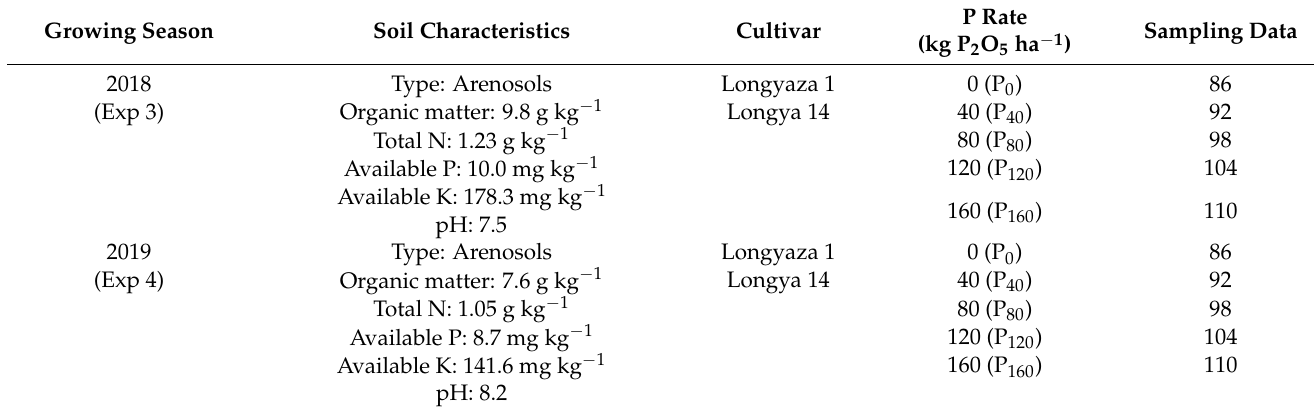
Table 2. Basic information at the Yongdeng site in the 2018 and 2019 growing seasons.